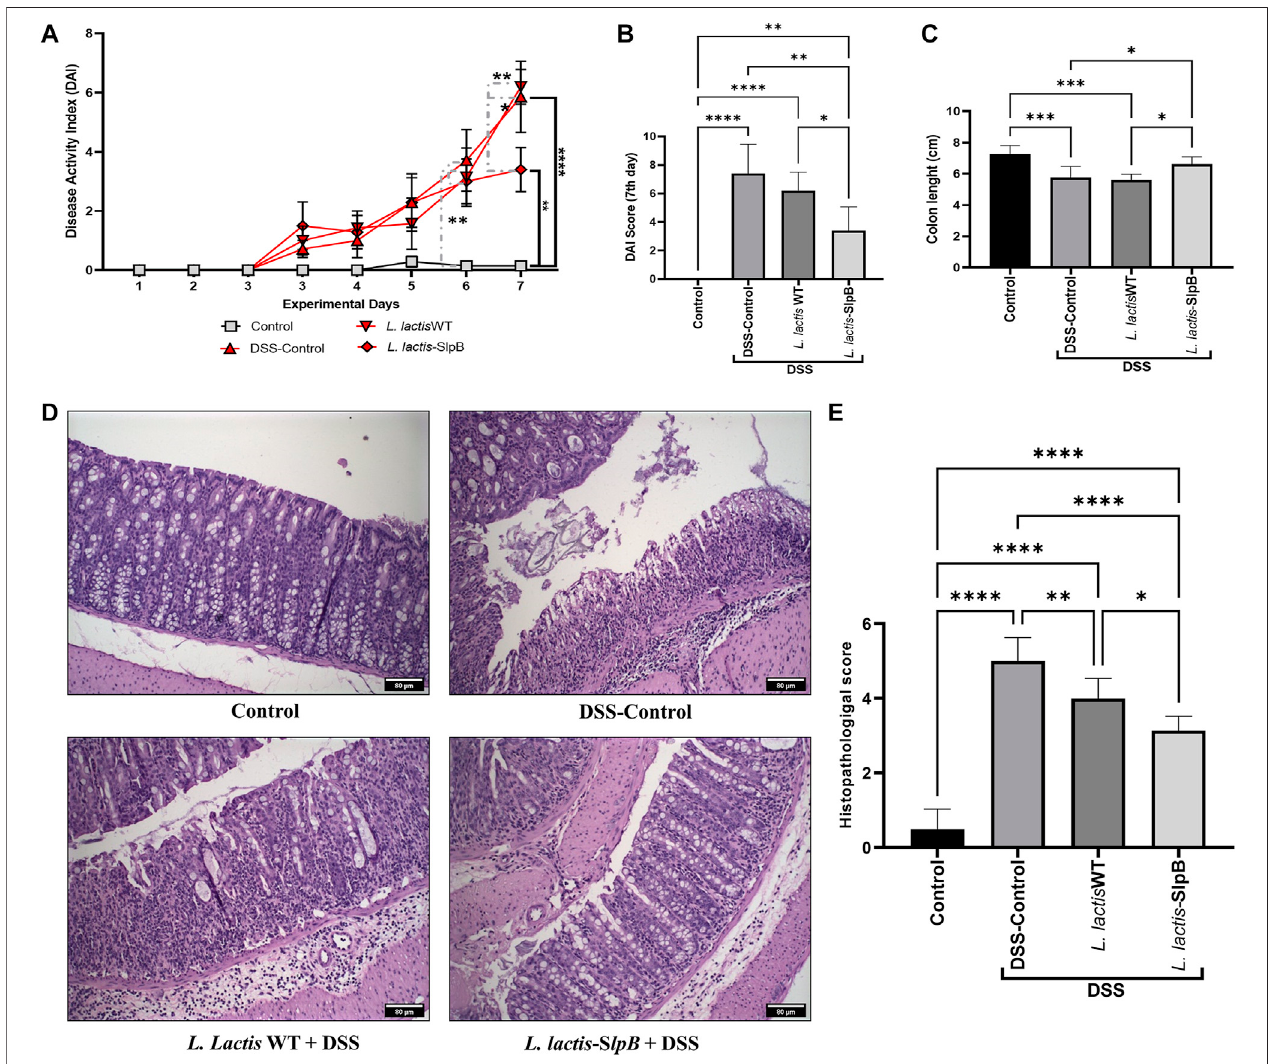
FIGURE 2 | L lactis -SlpB alleviates clinical symptoms in DSS-colitis mice model and reduces colon mucosal damage. Disease activity index over the seven experimental days (A) , at the last day (B) , Colon length analysis (C) , Micrograph images of the histopathological analysis of the colon tissue (D) and analysis of the histopathologicalscore (E) areshown.Theslideswerestainedinhematoxylinandeosin(H&E)andanalyzedunder × 20magni fi cation.Thetwo-wayANOVA (A) ,one-way ANOVA (B) , and Tukey ’ s post - hoc tests were used for the multiple comparisons (The data represent the mean ± SD of 12 mice per group). Asterisks represent statistically signi fi cant differences as follows: p p < 0.05, pp p < 0.01, ppp p < 0.001, pppp p < 0.0001.